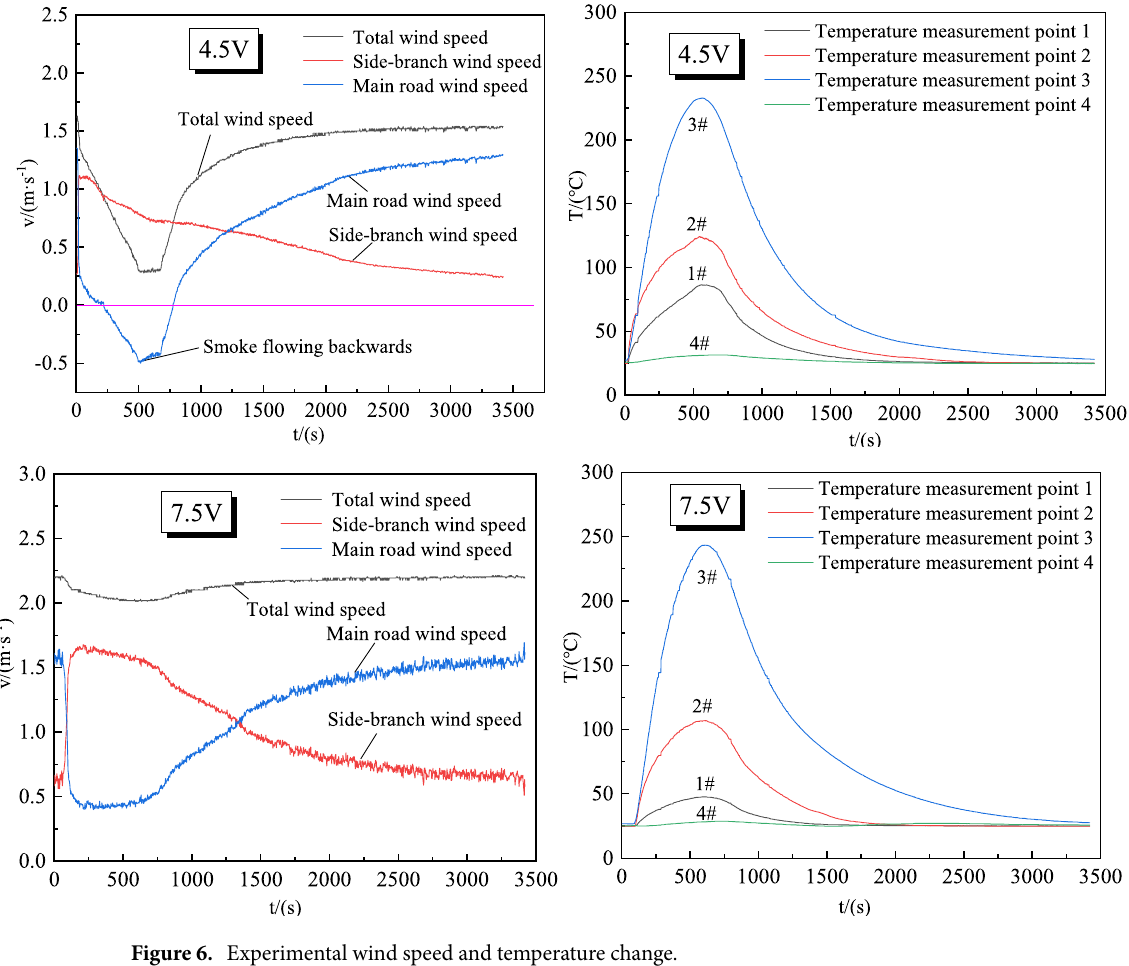
Figure 6. Experimental wind speed and temperature